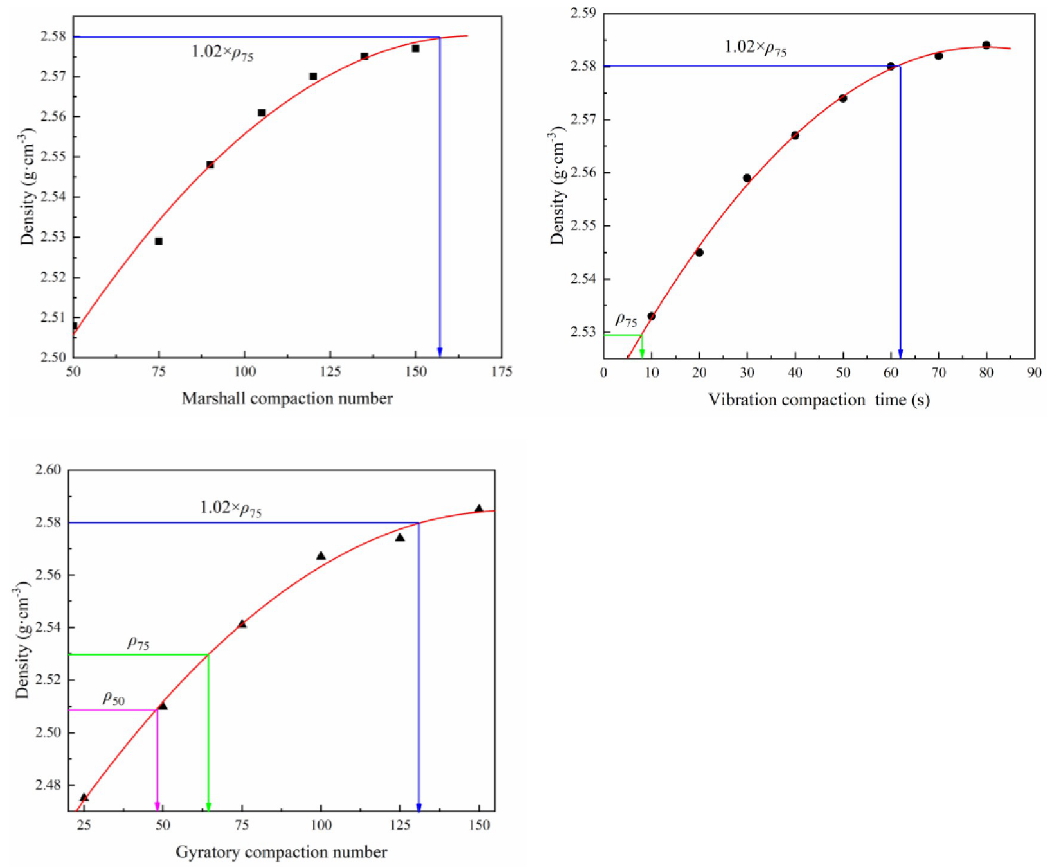
Fig 2. The relationship between compaction number (time) and specimen density. (a) Density versus Marshall compaction number (b) Density versus vibration compaction time. (c) Density versus gyratory compaction